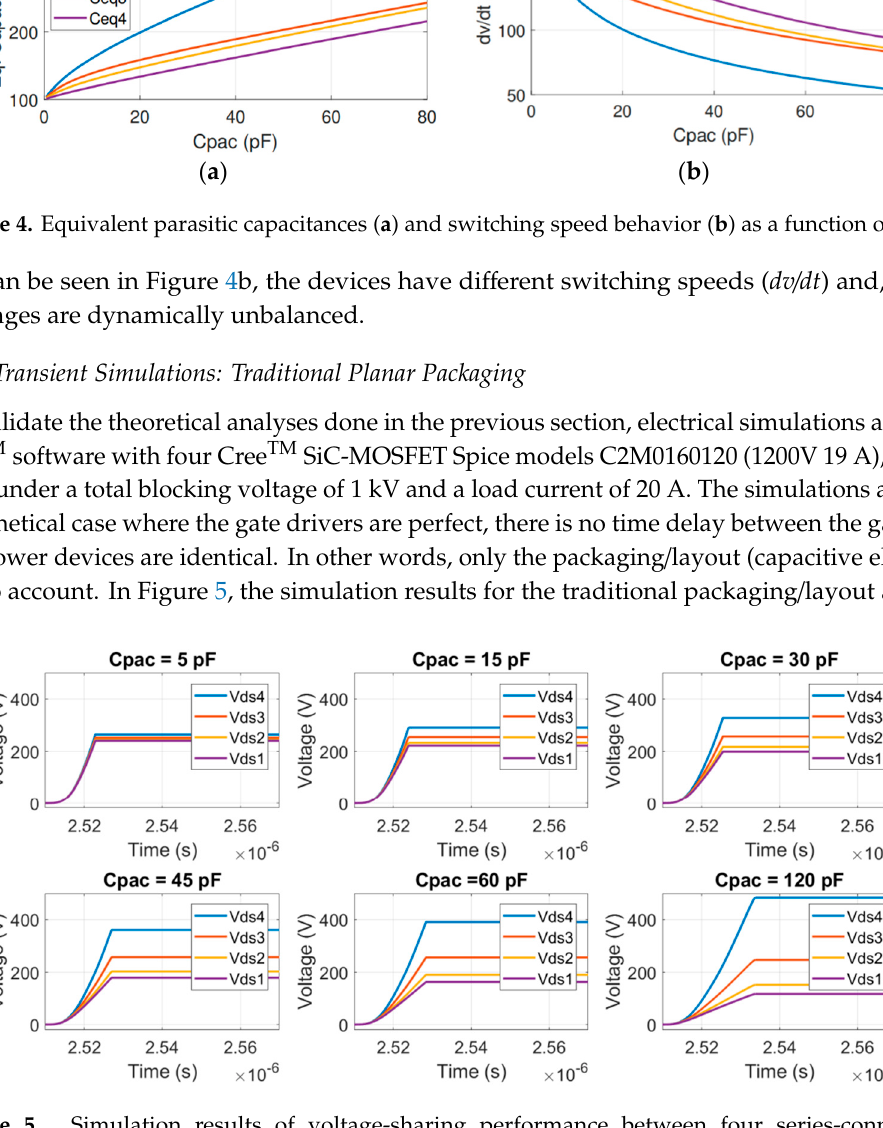
Figure 5. Simulation results of voltage-sharing performance between four series-connected SiC- MOSFETs in classical packaging/layout.